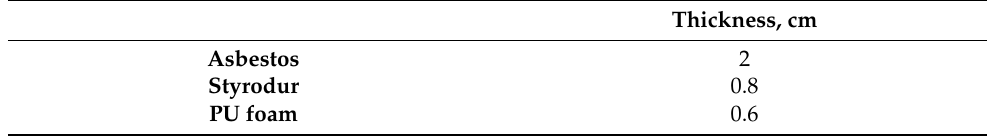
Table 4. Thickness of the layers of insulating materials corresponding to the